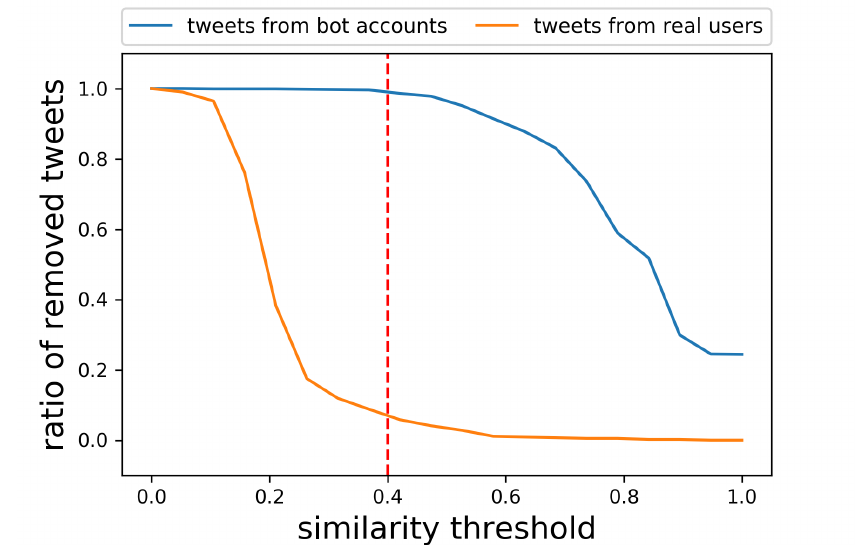
Figure 7. Ratio of correctly removed tweets from bot accounts and falsely removed tweets from real = 0.4 gave the best results, removing 99% of the tweets from bot accounts without users. Setting Sim con th falsely removing many tweets (less than 10%) from real users. Setting Sim con higher would miss more th tweets from bot accounts, while setting Sim con lower would falsely remove tweets from real th